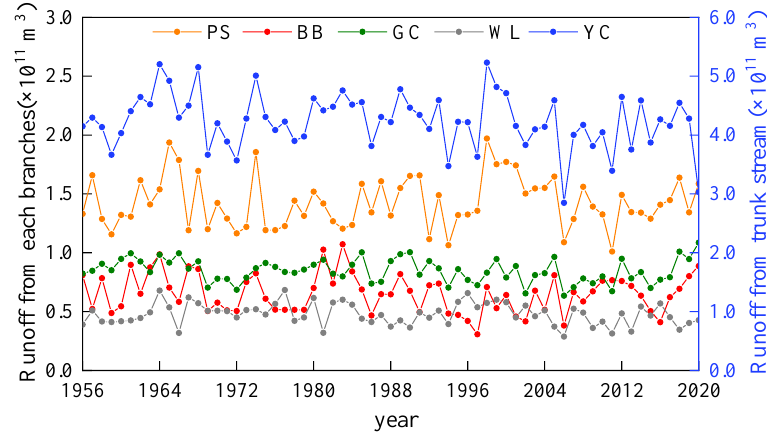
Figure 2. Average annual runoff in the upper reaches of the Yangtze River.